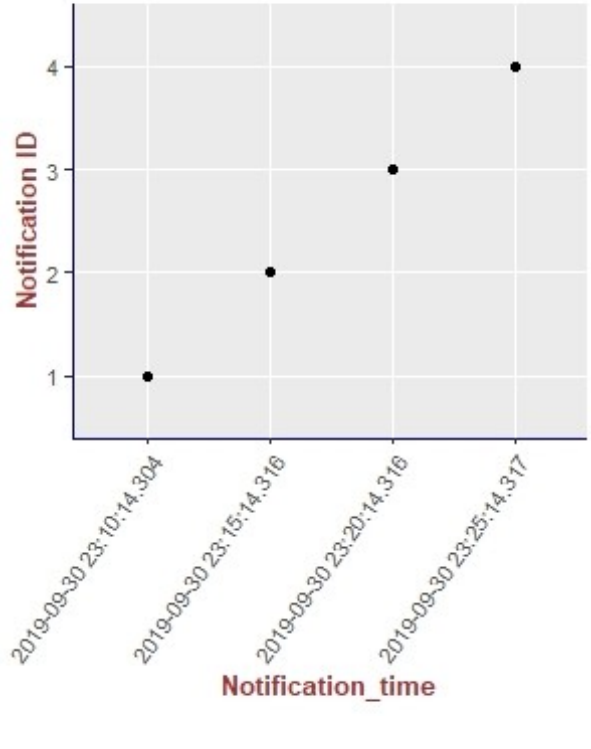
Figure 14. Illustration of the results of the delivery process related to all our